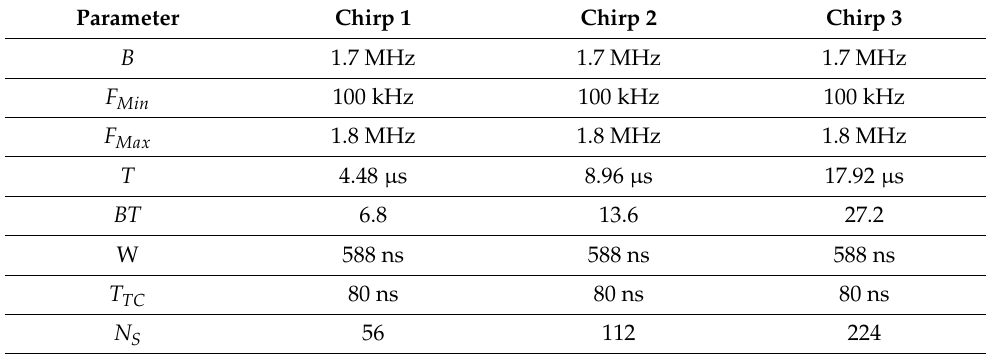
Table 1. Features of the